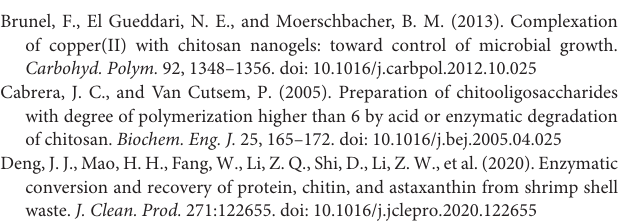
Supplementary Figure 1 | The Lineweaver–Burk plot of the Csn-SH activity. Supplementary Figure 2 | TLC analysis of (GlcN) 2 − 6 hydrolysates prepared with Csn-SH. Supplementary Table 1 | Substrate specificity of purified